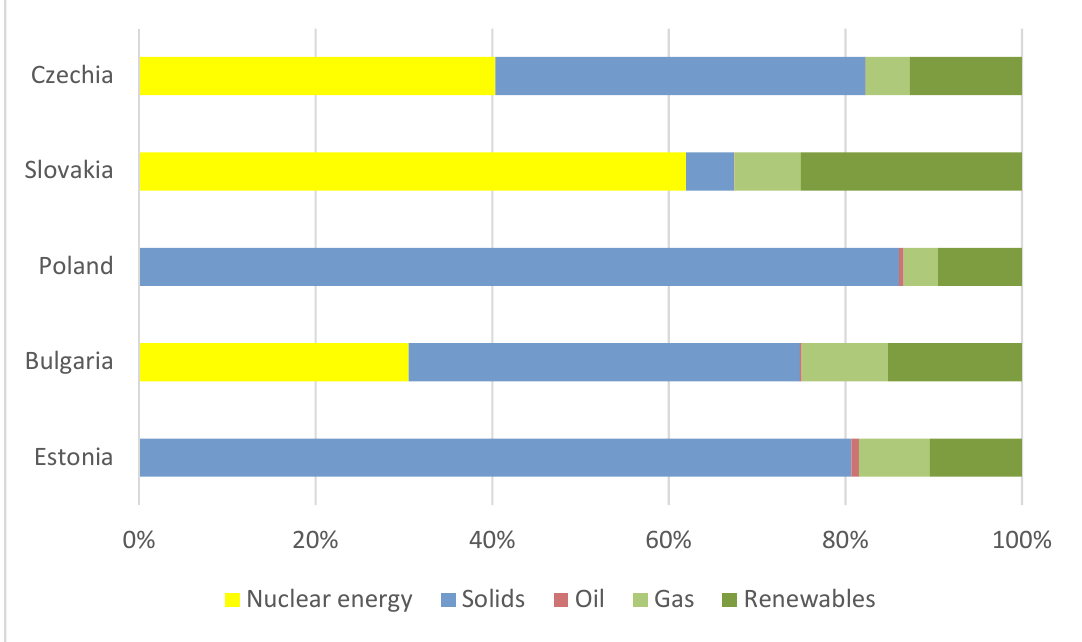
Figure 10. Structure of energy mixes for the fifth cluster . Source (own elaboration).